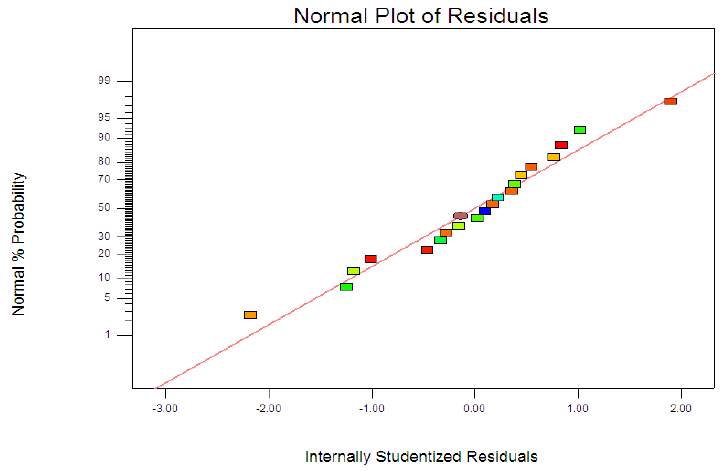
Figure 4. Normal probability plots of the residuals.